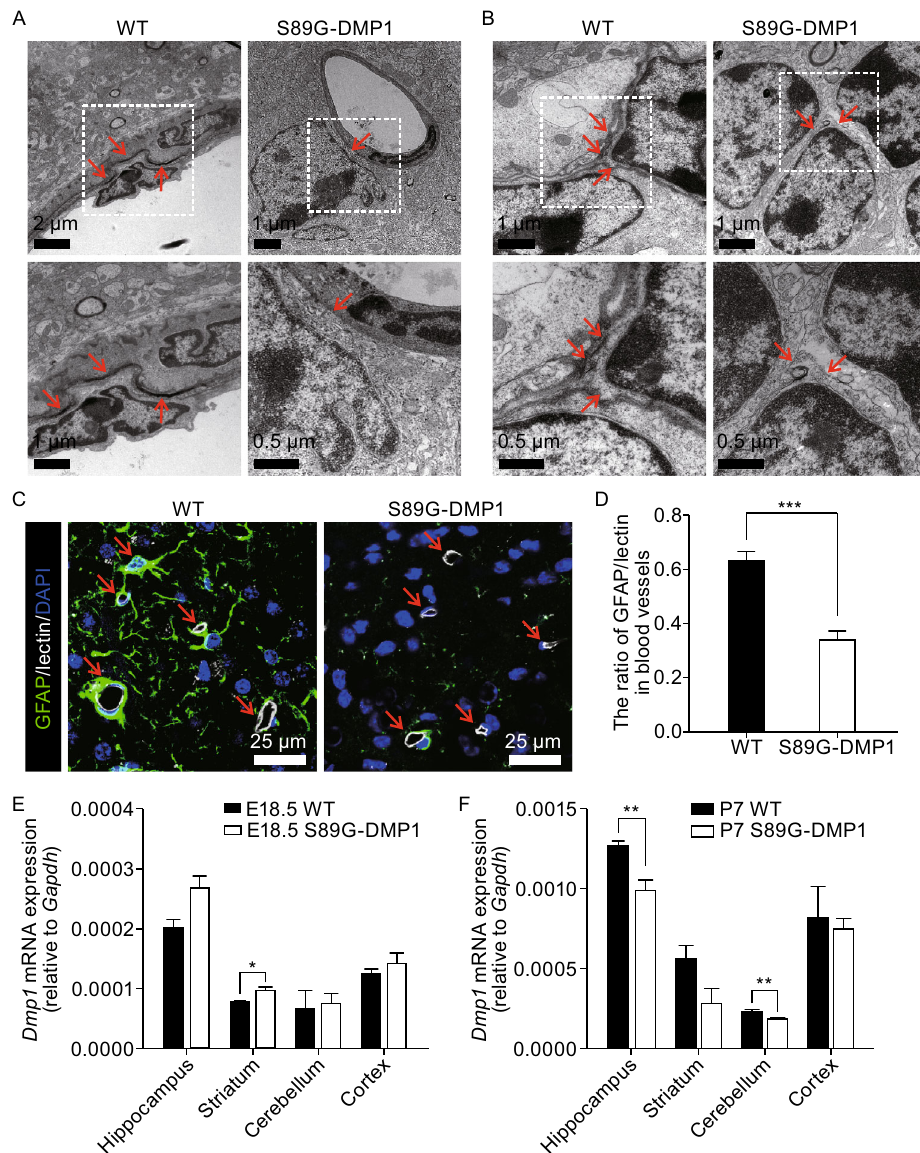
Figure 2. S89G-DMP1 inhibits astrocytes to locate to and wrap around blood vessels. (A) Transmission electron microscopeshowed loosened cell adhesion between astrocytes and vascular endothelial cells in the retrosplenial granular cortex (RSG) of S89G-DMP1 mice; and between astrocytes themselves (B); (C) Representative images of GFAP/lectin in the RSG, indicative of attenuated targeting of astrocytes to blood vessels in S89G mice; (D) Quanti fi cation plot for (C). ***, P < 0.001. At least 23 random captures from7 mice per genotype were quanti fi ed. (E) Dmp1 mRNA decreased in different brain regions at embryonic